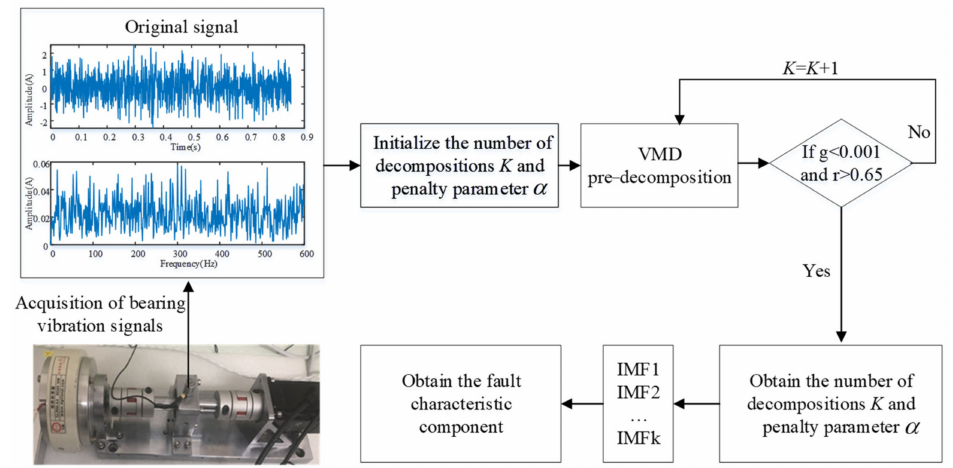
Figure 1. VMD signal decomposition